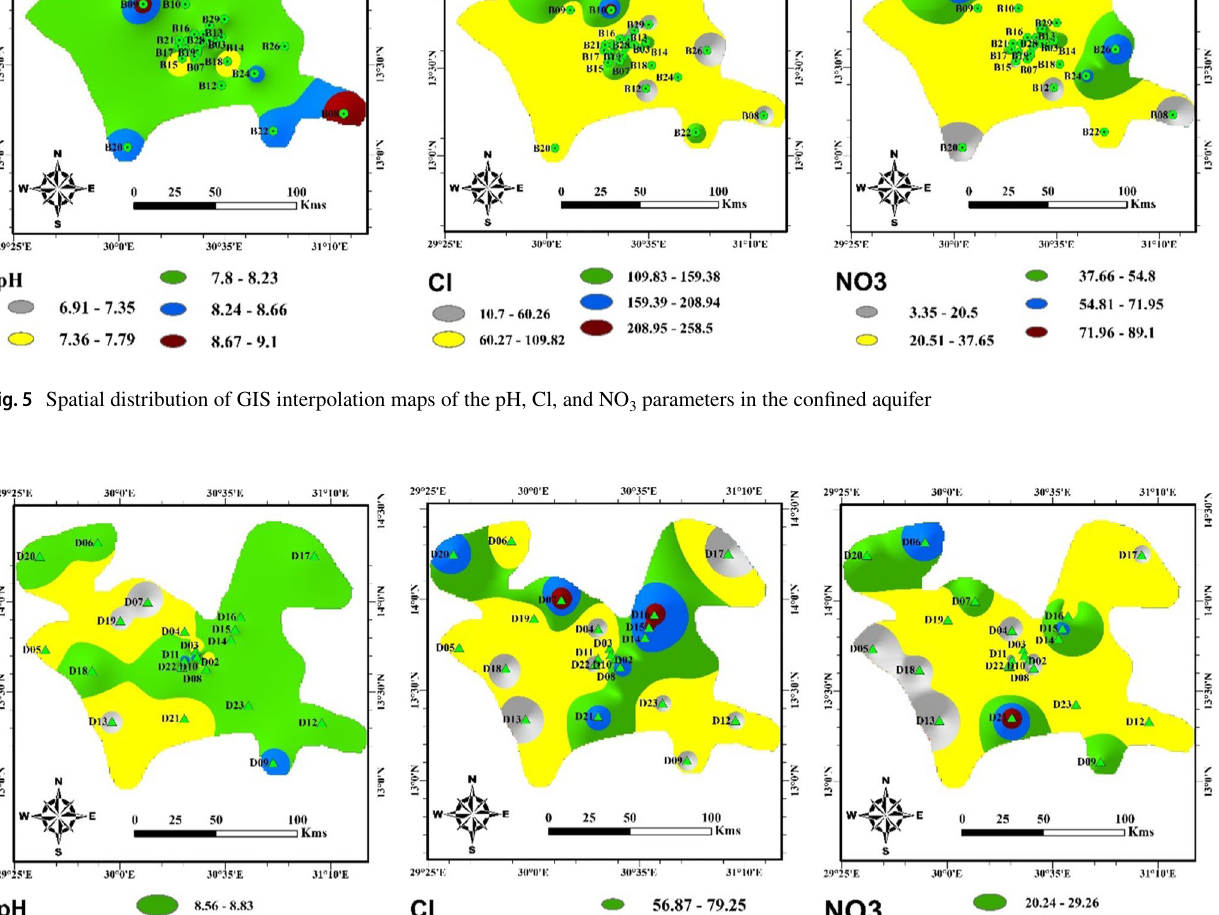
3 parameters in an unconfined